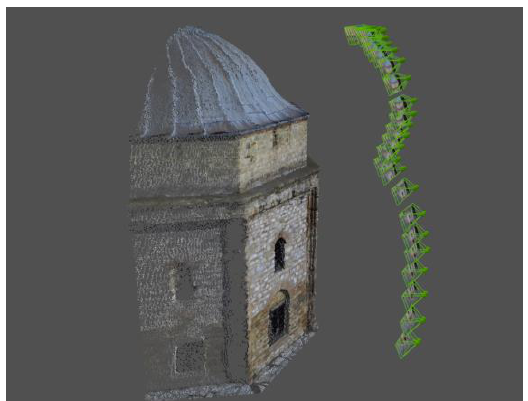
Figure 7: SfM/MVS reconstruction of ZED video frames using Pix4Dmapper Pro.